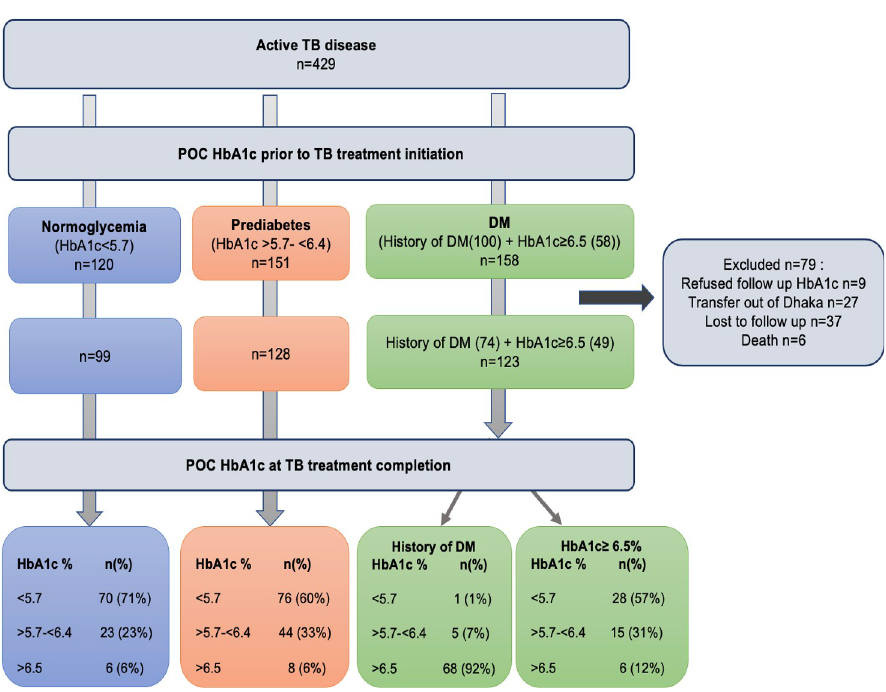
Fig 1. Flow diagram describing patient point-of-care Hemoglobin A1c (POC HbA1c) levels and history of diabetes mellitus (DM) at initiation and completion of tuberculosis (TB) treatment.